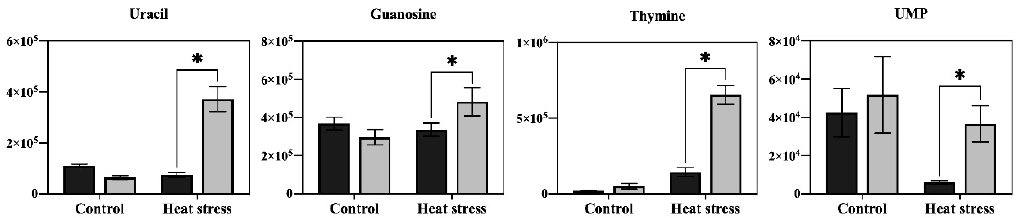
Figure 7. Effects of exogenous application of aspartate (Asp, 2 mM) on the content of nucleotides in leaves of perennial ryegrass under control temperature and heat stress (30 d of treatment). Vertical bars over the column represent standard errors of a given data point, and * represents significant differences between water and Asp under control temperature and heat stress based on the LSD test at p = 0.05.